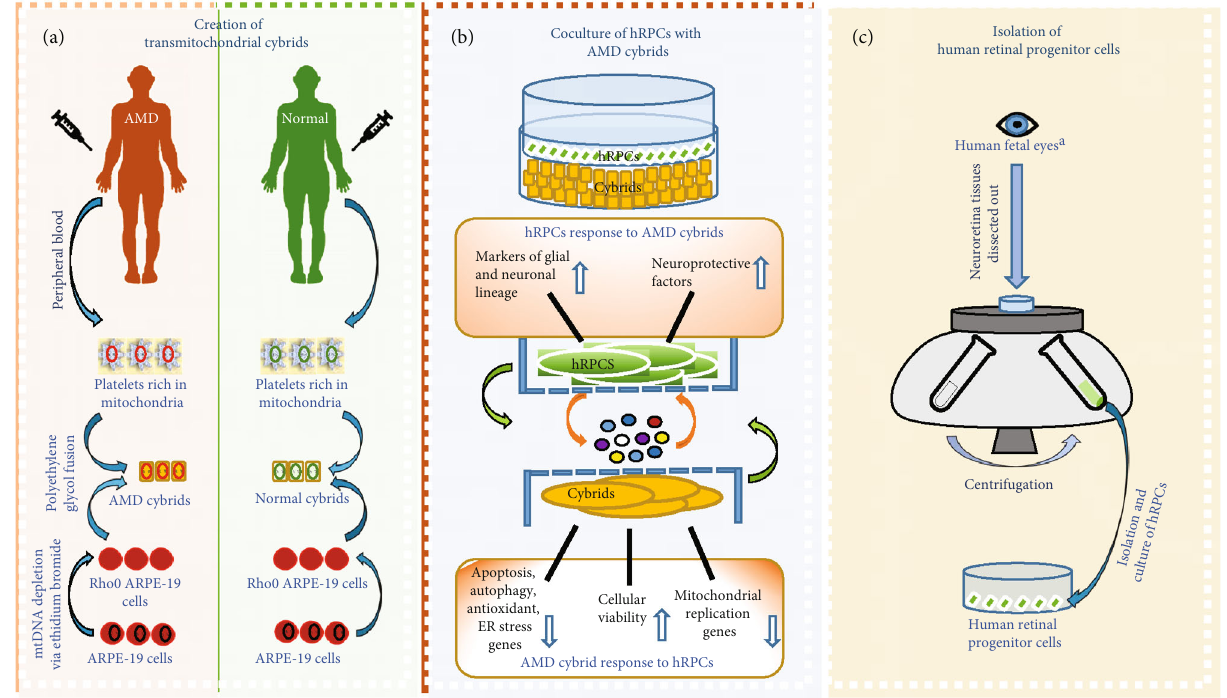
Figure 1: System design. (a) A schematic of the process for creating AMD and normal cybrids using polyethylene glycol fusion of mitochondria-free ARPE-19 (Rho0) cells and mitochondria-rich platelets isolated from peripheral blood of AMD patients or age-matched normal patients. (b) A schematic which illustrates the bidirectional signaling pathway mediated by the coculture of hRPCs with AMD cybrids. (c) A schematic of the process for isolating human retinal progenitor cells from human fetal eyes. a Human fetal eyes (17-20 weeks gestational age) were obtained from the therapeutic termination of